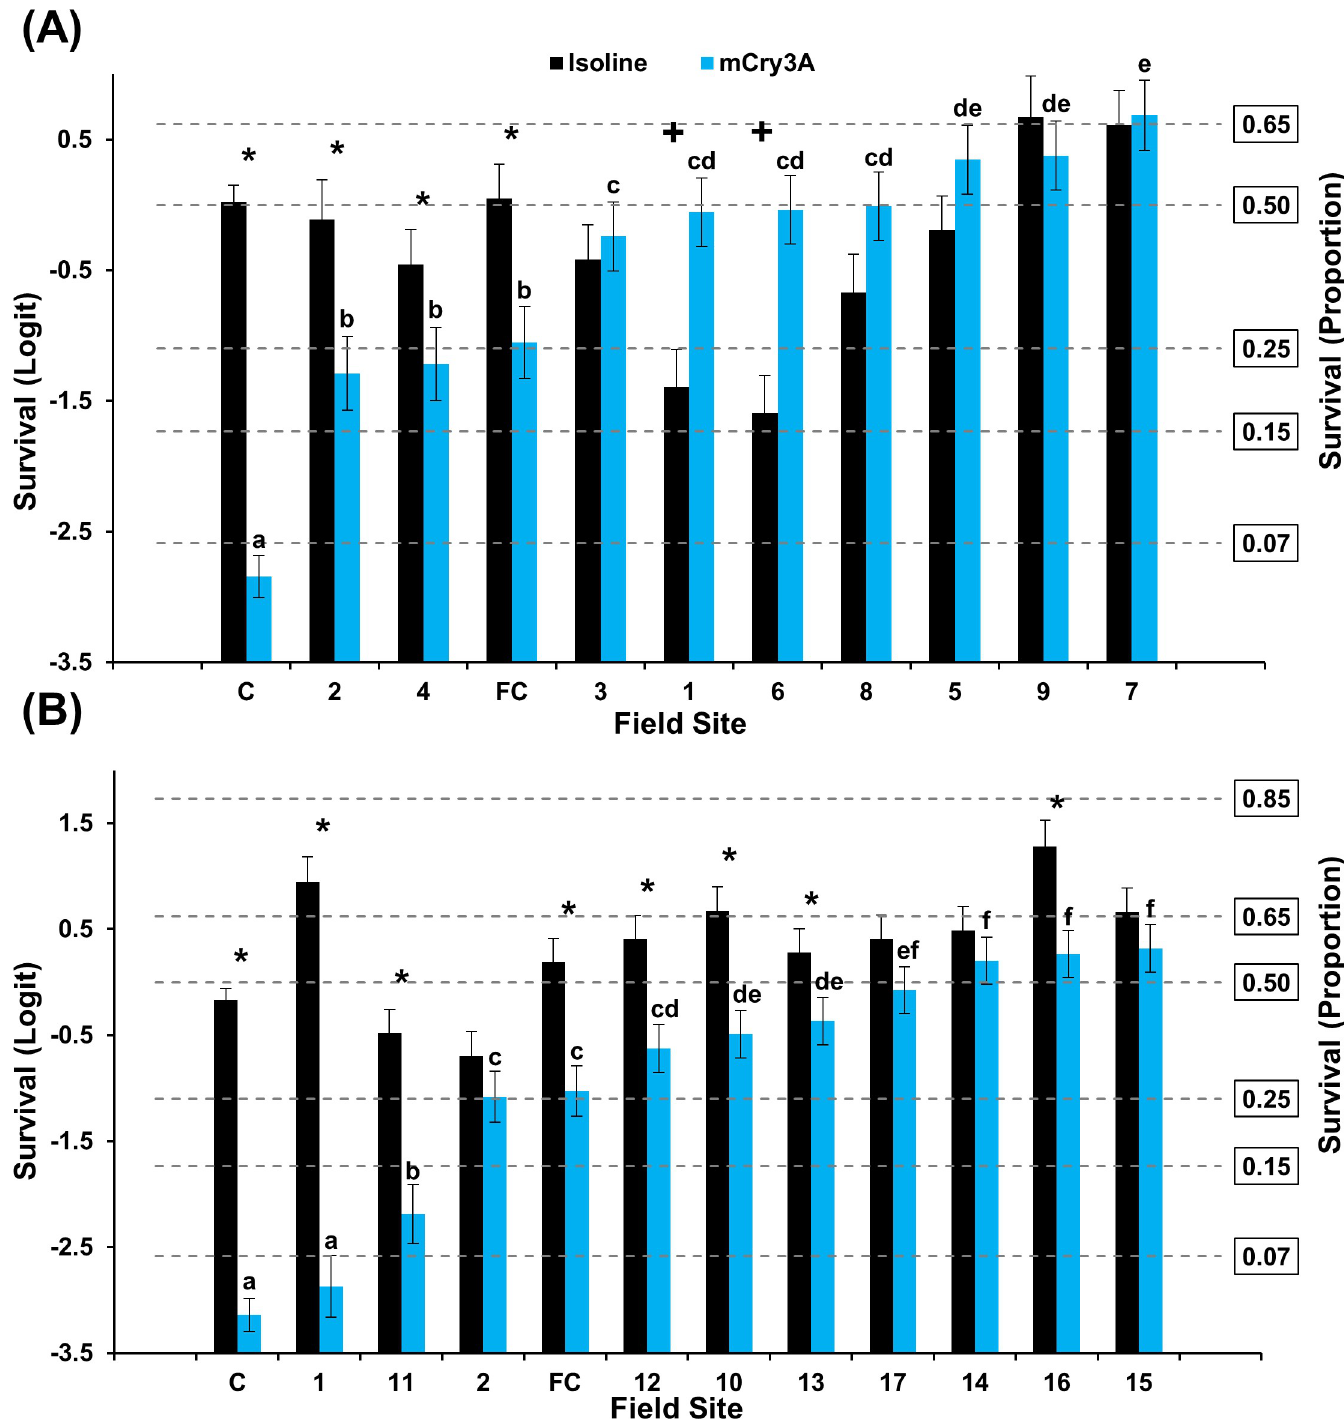
Fig 3. Mean WCR larval survival ( ± SE) of Keith County populations on mCry3A and its isoline. (A) 2016 bioassays. (B) 2017 bioassays. C = composite lab control; FC = field control. � indicates significantly higher survival on isoline compared to mCry3A. + indicates significantly higher survival on mCry3A compared to the isoline. Within years, mCry3A means with the same letter were not significantly different (generalized linear model, P > 0.05; LSMEANS option).